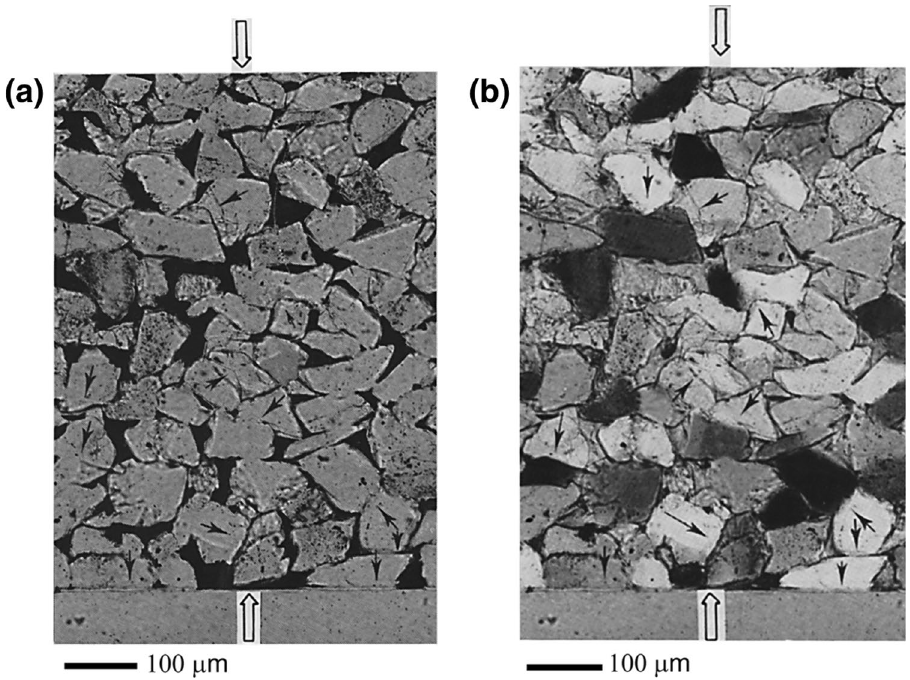
Figure 1. Overview photomicrographs of quartz sand compacted wet at 350 °C in test QC13. ( a ) Plane polarized light, with pores colored black. ( b ) Crossed polars. Both photomicrographs show the same part of a thin section cut parallel to the cylindrical axis of the sample (i.e. parallel to the direction of the applied effective stress, indicated by the open arrows). Notice the grain contact truncation and grain indentation microstructures (thin arrows). Just visible at the bottom is the polished cylindrical quartz crystal. Note conspicuous grain contact truncation of quartz grains from the matrix against this